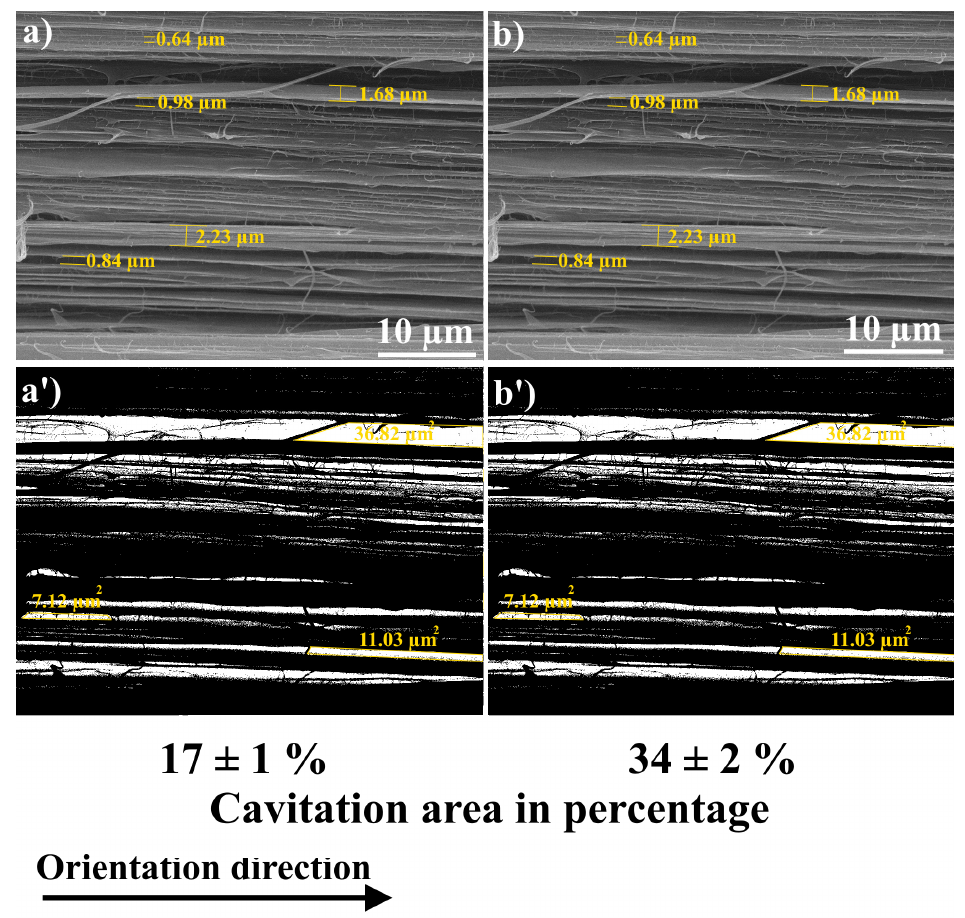
Figure 7. SEM micrographs of fibrillar structure for UHMWPE films obtained by second thermal orientation regime: ( a )—UHMWPE/1.0 wt. % PE-wax/0.01 wt. % GNP/PAN (average pore size is 1.8 ± 0.2 µm), ( b )—UHMWPE/1.0 wt. % PE-wax/2.0 wt. % GNP/PAN (average pore size is 2.2 ± 0.3 µm);